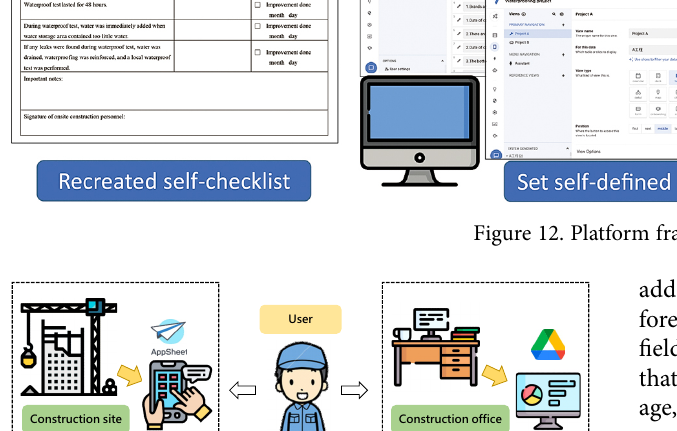
Figure 13. Application of mobile device for inspection